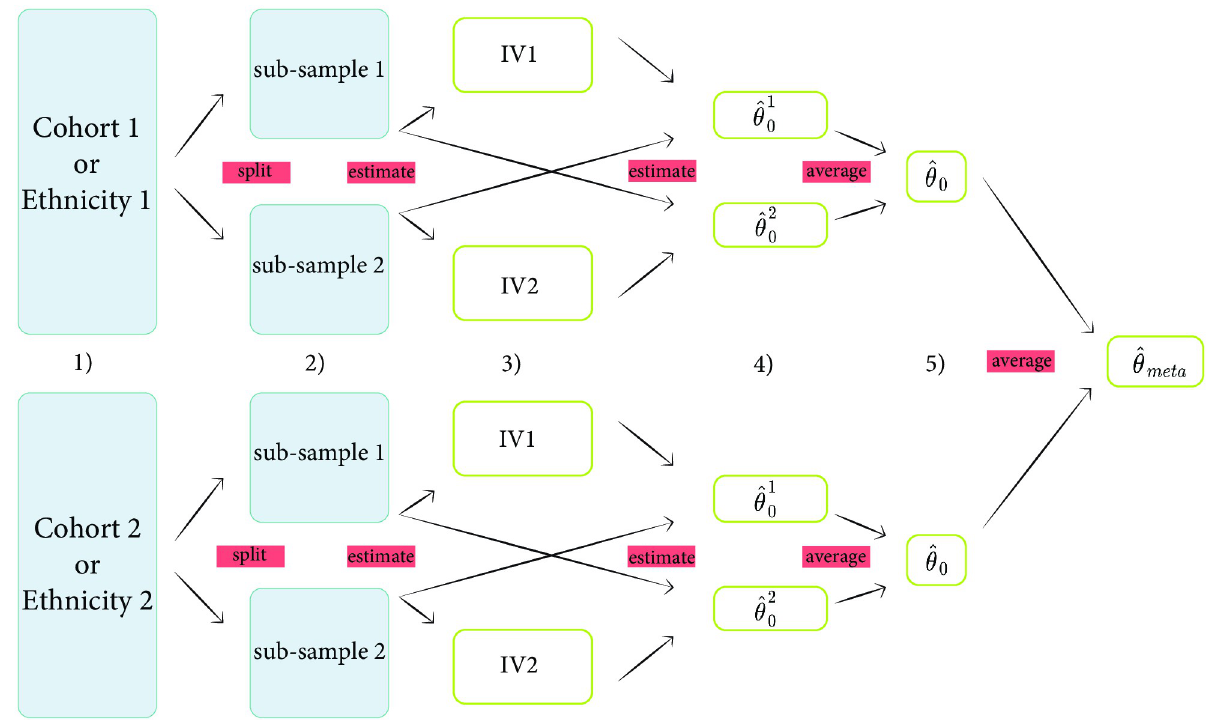
Fig 4. Schematic overview of the application of CFMR to a dataset comprising two ethniticies. In step 1, the two ethnicities are first separated into two distinct datasets, where each dataset contains individuals of the same ethnicity. In step 2, the dataset is split at random for each ethnicity. In step 3, two separate GWASs are performed: the first using sub-sample 1 and the exposure and the second using sub-sample 2 and the exposure. The predictors of the exposure are subsequently built based on sub-sample 1 (IV1) and sub-sample 2 (IV2). Step 4 refers to the 2SLS using IV1 on sub- sample 2 and IV2 on sub-sample 1, and, for each dataset, the two 2SLS from step 3 are averaged. Finally, in step 5 the two estimates are meta-analyzed to obtain the final